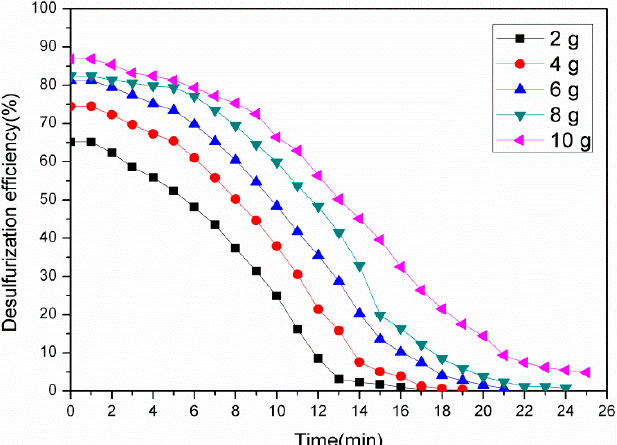
Figure 4. Effect of change of carbon dosage on SO 2 adsorption behavior (operated at 60 °C, for 2, 4, 6, 8, 10 g samples, 2000 ppm SO 2 , 5% O 2 , N 2 to balance and 1.65 L/min total flow rate).